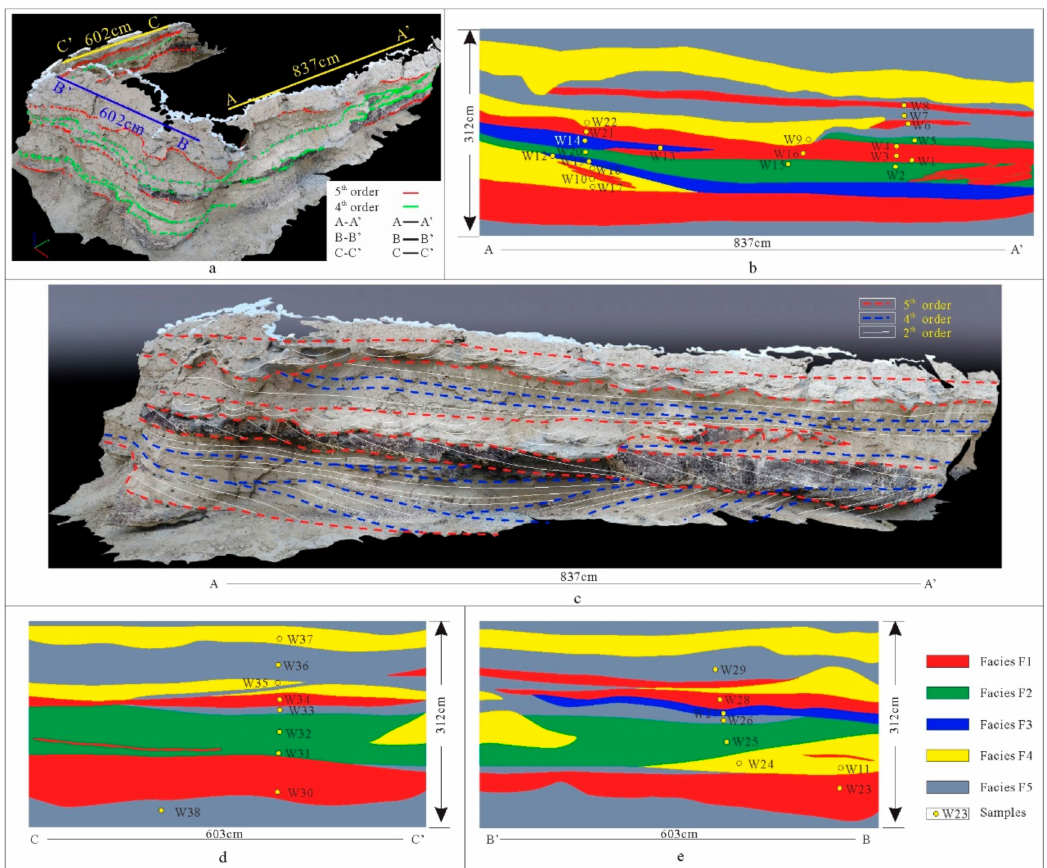
Figure 3. Digital outcrops and architectural element analysis results. ( a ) The digital outcrops established by the unmanned aerial vehicle (UAV); ( b , d , e ) the digital sections; ( c ) the result of architectural element analysis. The yellow dots in ( b , d , e ) are the samples. Red, green, blue, yellow, and gray in ( b , d , e ) are facies F1, F2, F3, F4, and F5,